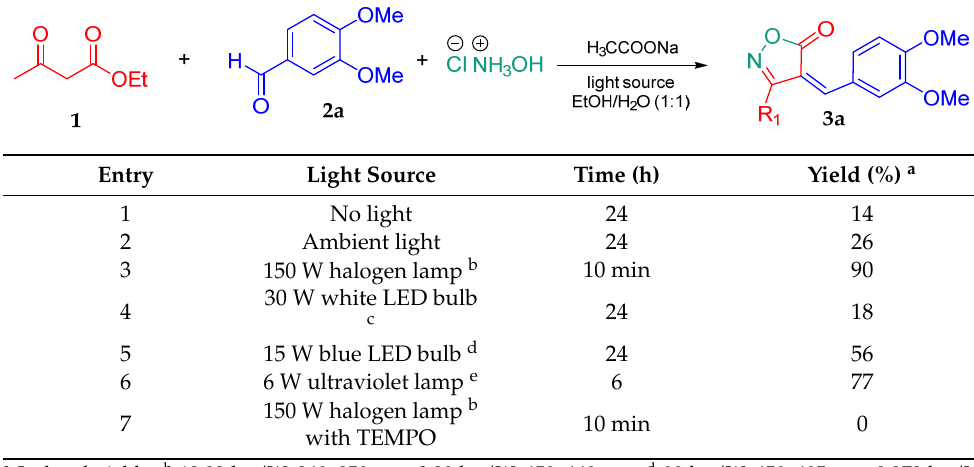
Table 2. Effects of different light sources on the MCR reaction.